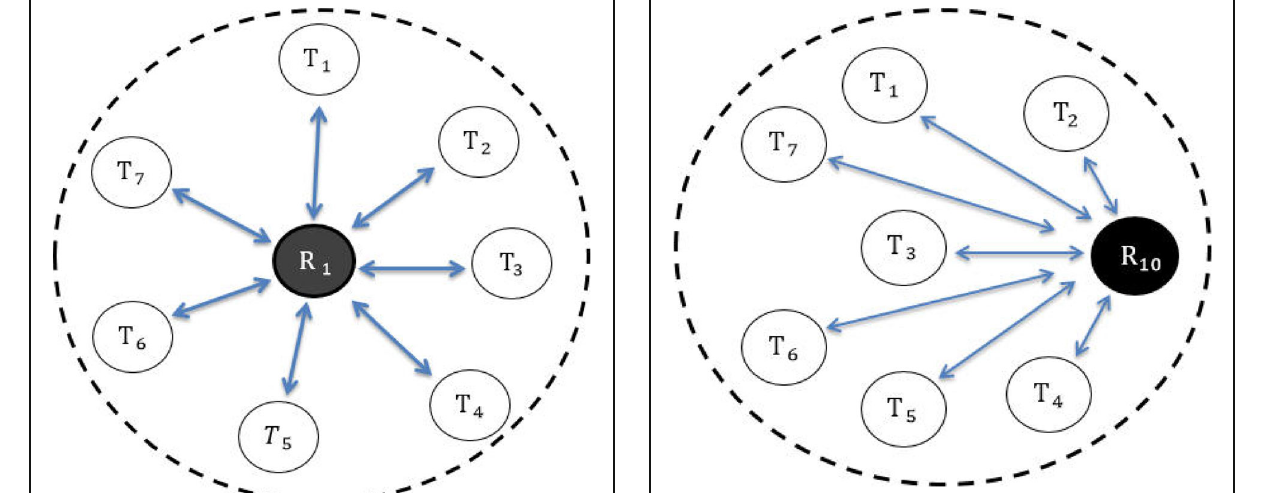
Fig. 5 Switch card reader and communication between cluster members and new card